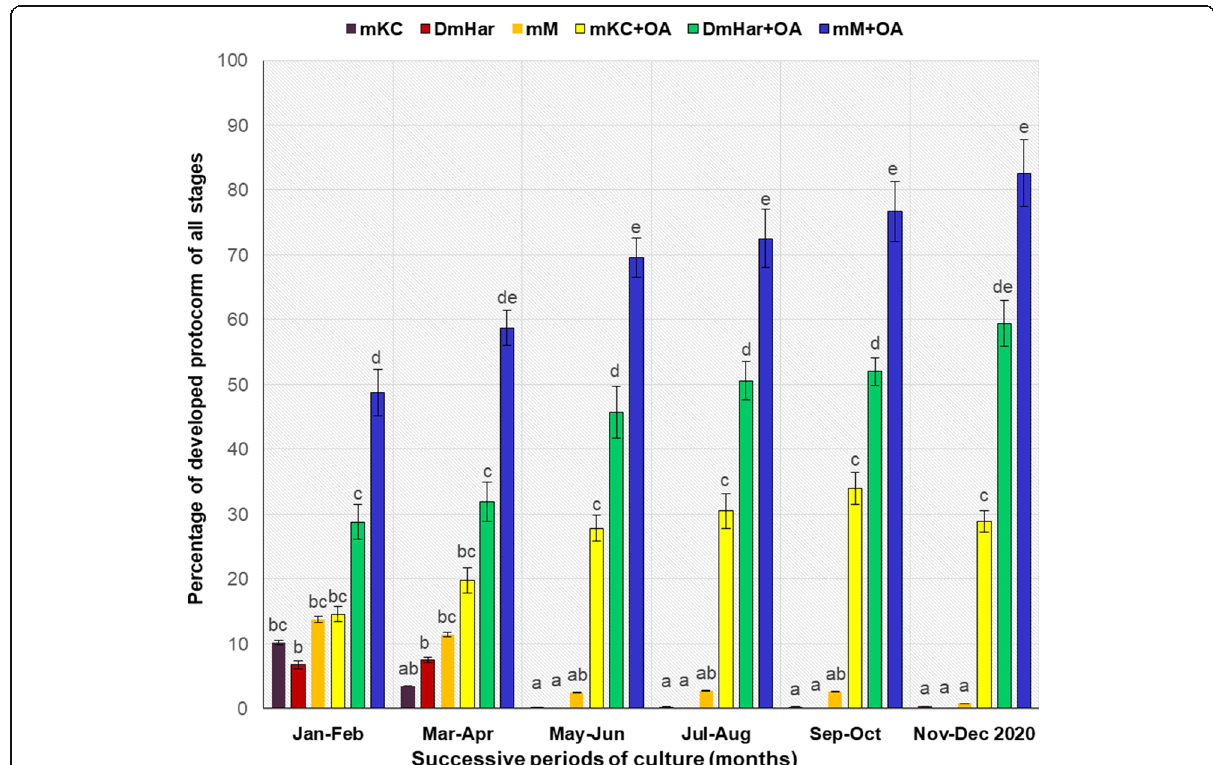
Fig. 4 Effects of growing medium composition and organic additives on Orchis militaris protocorm formation. # Means having the same superscript letters in a column were not significantly different by Duncan ’ s multiple range test ( p <